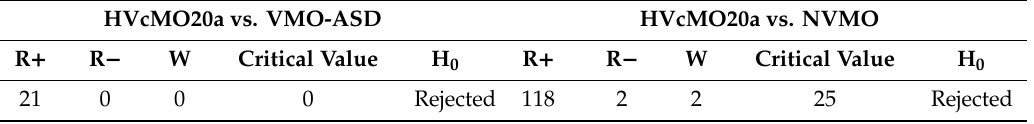
Table 4. Wilcoxon test regarding PR. The sum of ranks of comparisons where HVcMO20a outdoes the other algorithm (either VMO-ASD or NVMO) is R + , and R − is the opposite sum. If the W statistic is equal or less than the corresponding critical value, the null-hypothesis is